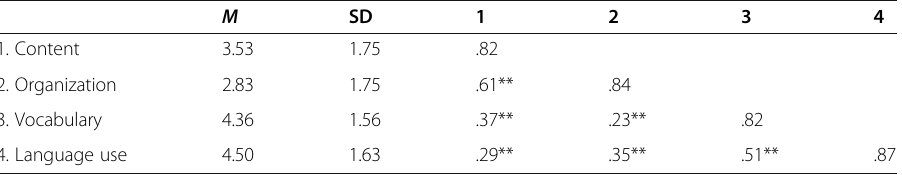
Table 3 Correlations for expert ratings